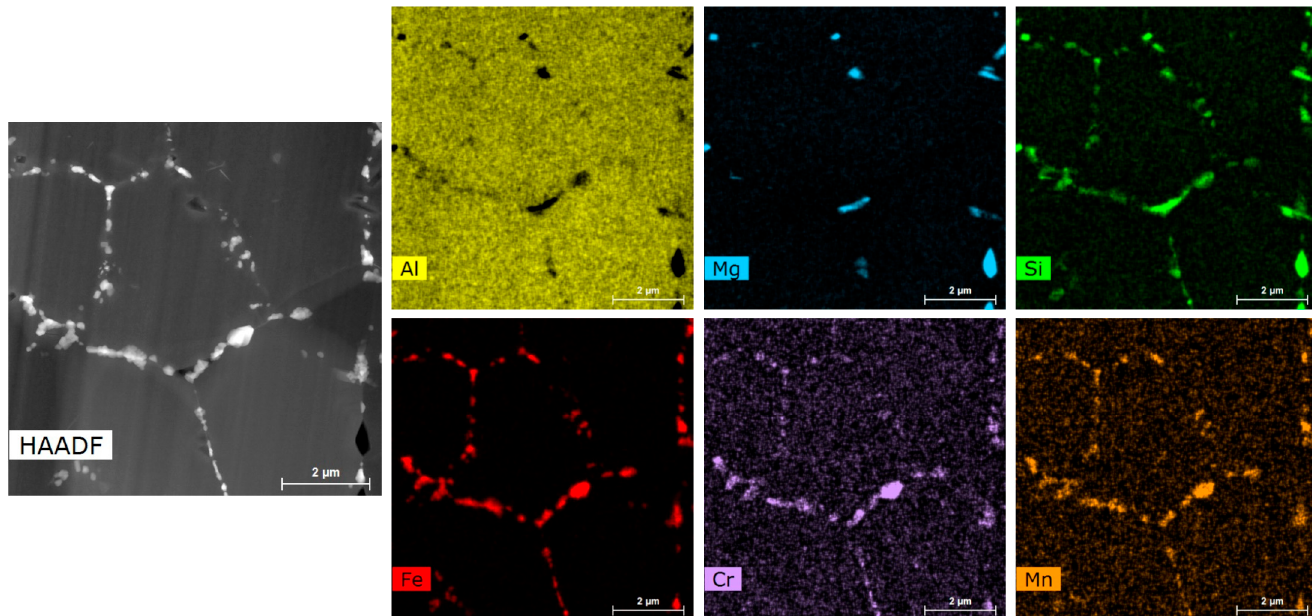
Figure 12. The subfigure labeled with “HAADF” presents a HAADF-STEM micrograph affiliated with a collection of subgrains and sub-granular boundary regions, with particular attention afforded to the discrete intermetallic precipitates along the polycrystalline boundaries within a thermally pre-processed Al 6061 gas-atomized powder particle. Thermal pre-processing was achieved via a heat treatment hold time of 60 min and a hold temperature of 540 °C. The colored micrographs labeled with Al, Mg, Si, Cr, Mn, and Fe present the respective EDS-derived elemental maps for the area presented in the HAADF micrograph. Note that the scale bar affiliated with each micrograph is 2 μ m.